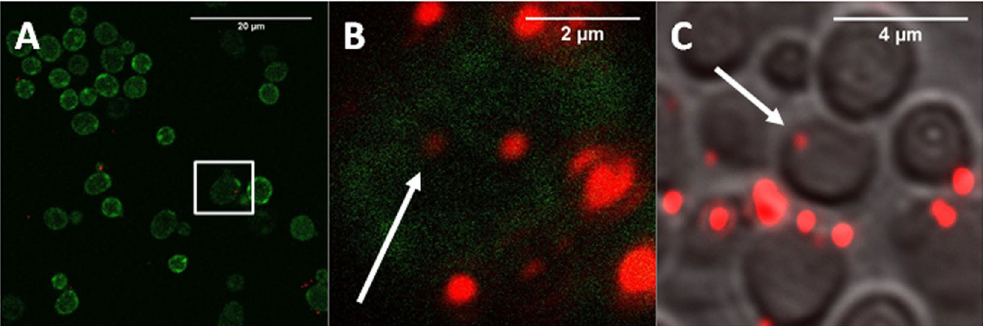
Figure 1. Qualitative analysis of uptake of FNDs by Hxt6-GFP-expressing yeast cells. ( A ) Overview of FNDs and Hxt6-GFP-expressing cells after treatment with TMIX, incubation at 42 °C and treatment with 5% DMSO. ( B ) Close up of the boxed cell from A, with diamond particles inside (for better visibility of the diamond particles the contrast of the red channel has been increased). The arrow shows a particle that was not at any place associated with the cell membrane. ( C ) Embedded and sectioned (approximately 0.8 µ m thickness) cells, visualized using Differential Interference Contrast. The diamond particle indicated by the arrow is